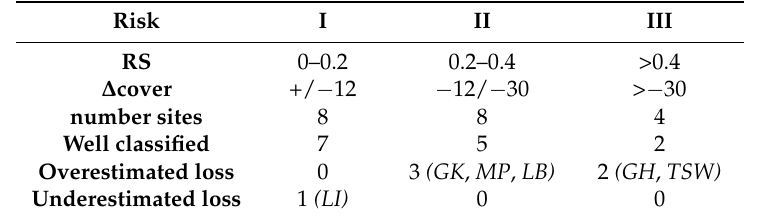
Table 5. Risk score thresholds associated with loss of seagrass cover and number of sites (name in bracket) well/miss-classified. The thresholds were derived from Figure 8a (dotted lines) and were selected to minimise the number of seagrass sites with an underestimated loss of seagrass cover (conservative approach).